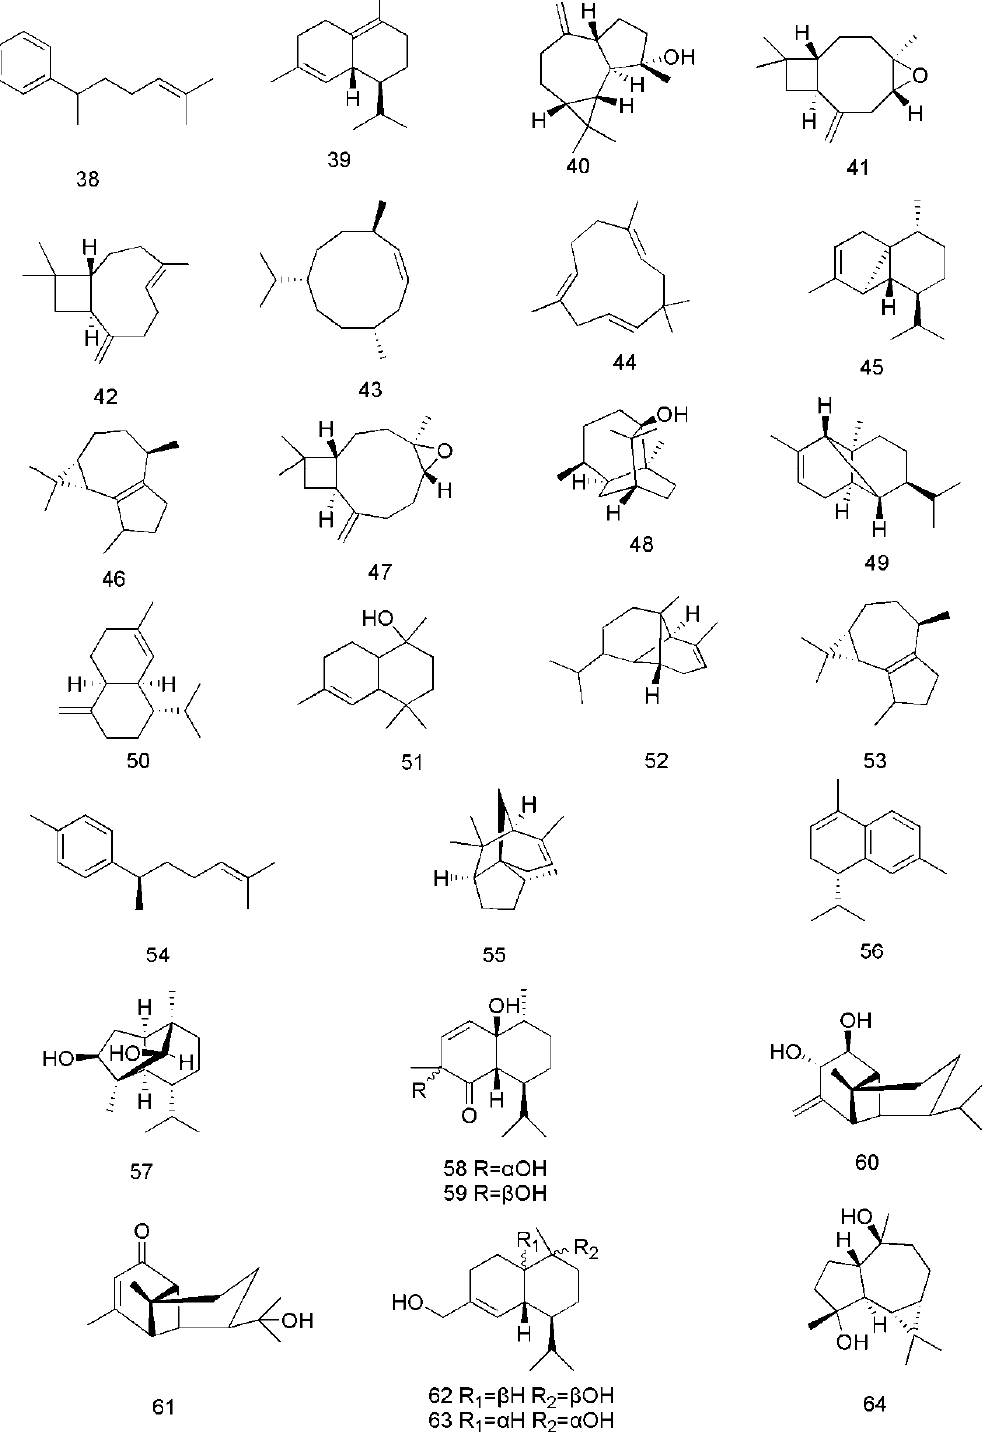
Figure 4. Chemical structures of the sesquiterpenoids in C. cassia .